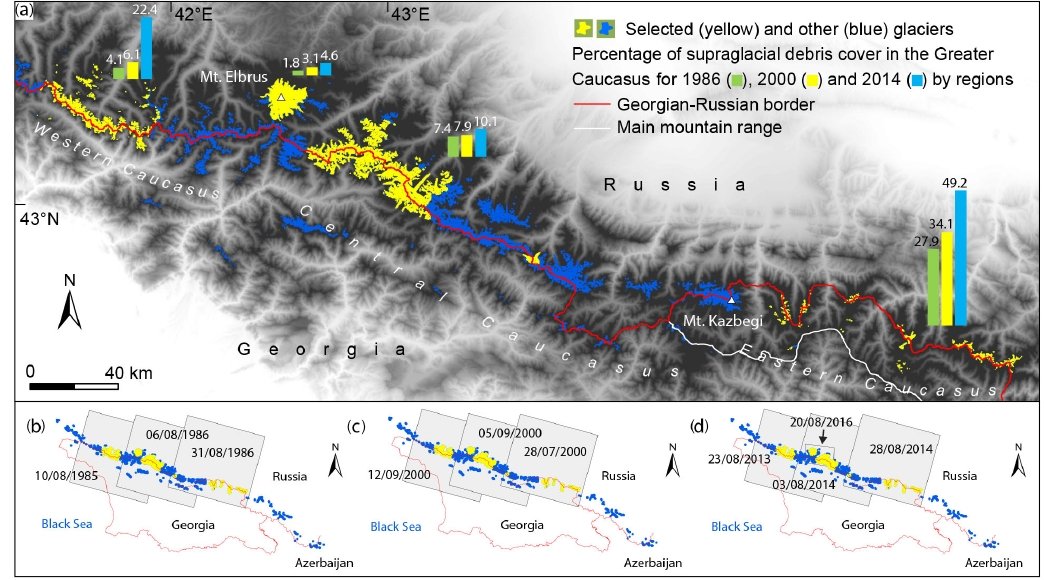
Figure 1. (a) Investigated area and selected glaciers by regions. (b) Three Landsat 5 Thematic Mapper (TM) satellite scenes from 1985 to 1986. (c) Three Landsat 7 Enhanced Thematic Mapper Plus (ETM + ) satellite scenes from 2000. (d) Three Landsat 8 Operational Land Imager (OLI) satellite scenes from 2013 to 2014 and one (smaller) SPOT satellite scene from